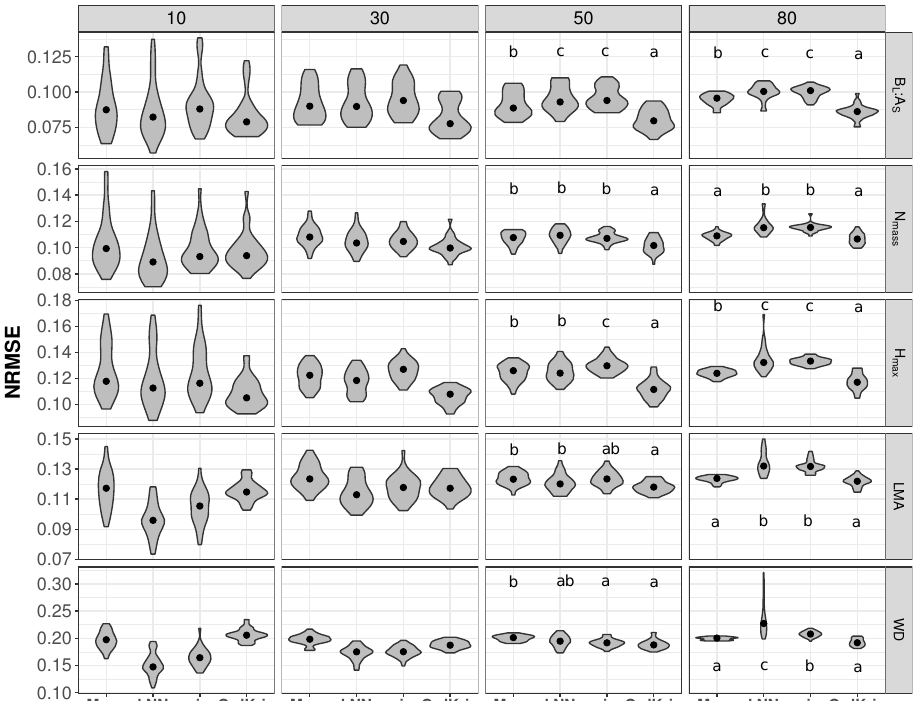
Figure 2. Trait-specific NRMSE at increasing missingness levels (10–80%) for different imputation methods: overall trait mean (Mean), mice (using only the trait matrix in the predictor set), kNN (using only the trait matrix for the distance calculation) and ordinary kriging (OrdKrig). Traits: leaf biomass to sapwood area ratio, B L : A S (tm − 2 ); leaf nitrogen per unit mass, N mass (%mass); maximum tree height, H max (m); leaf mass per area, LMA (mgcm − 2 ); wood density, WD (gmcm − 3 ). Letters denote results of multiple comparisons, in alphabetical order from highest to lowest